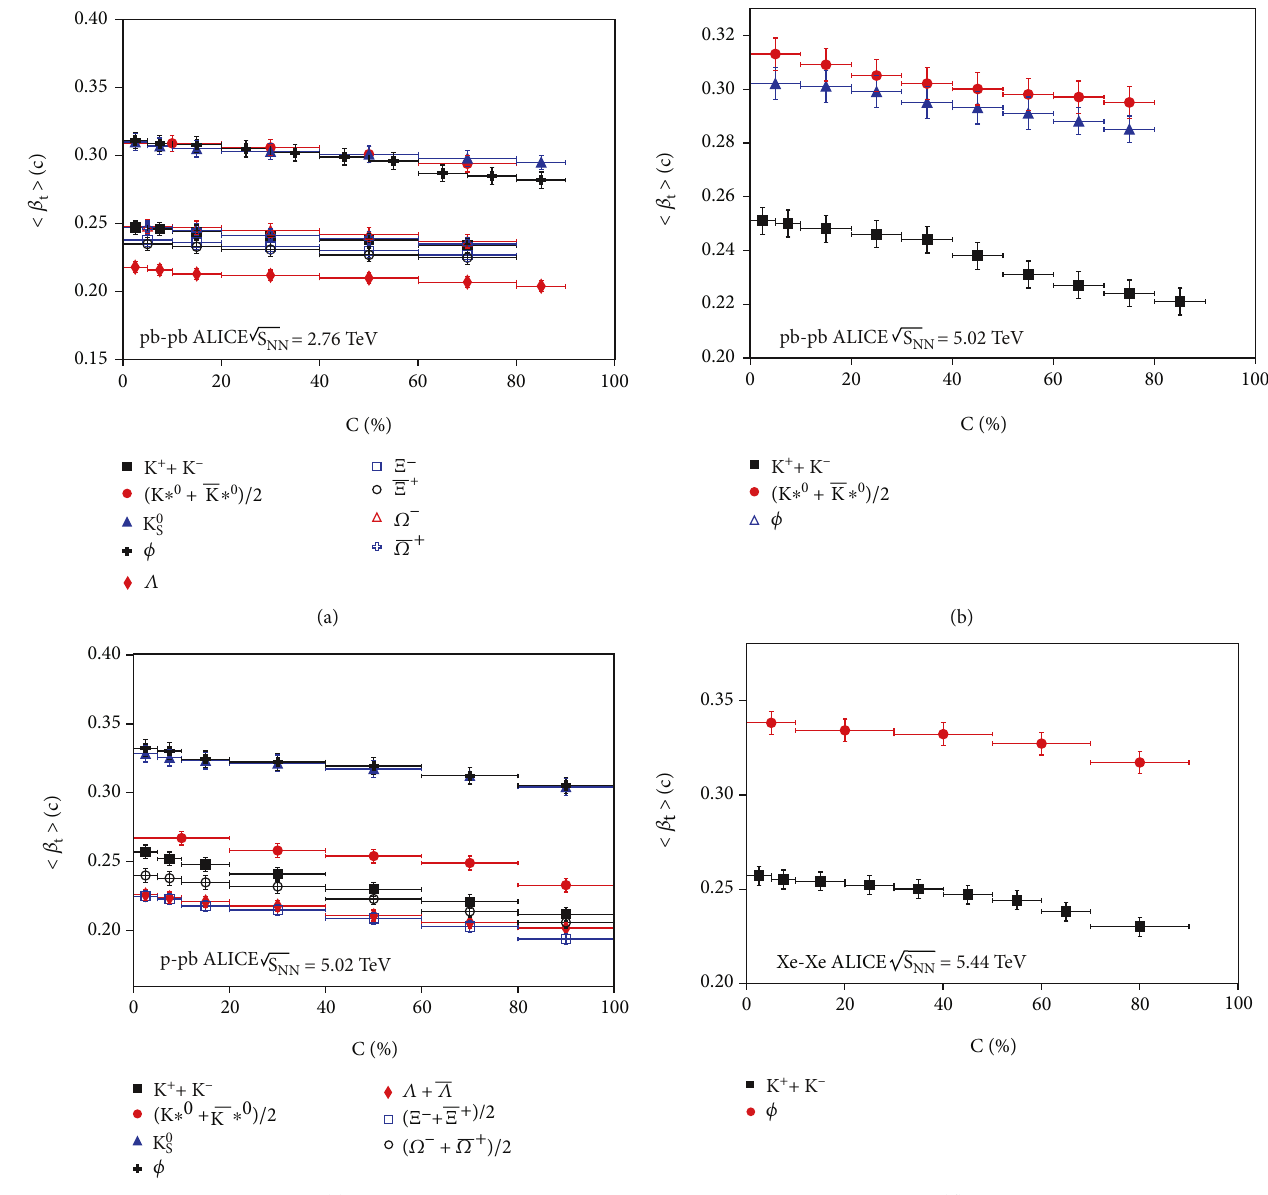
i on centrality and C in Pb – Pb, (c) p – Pb, and (d) Xe – Xe t